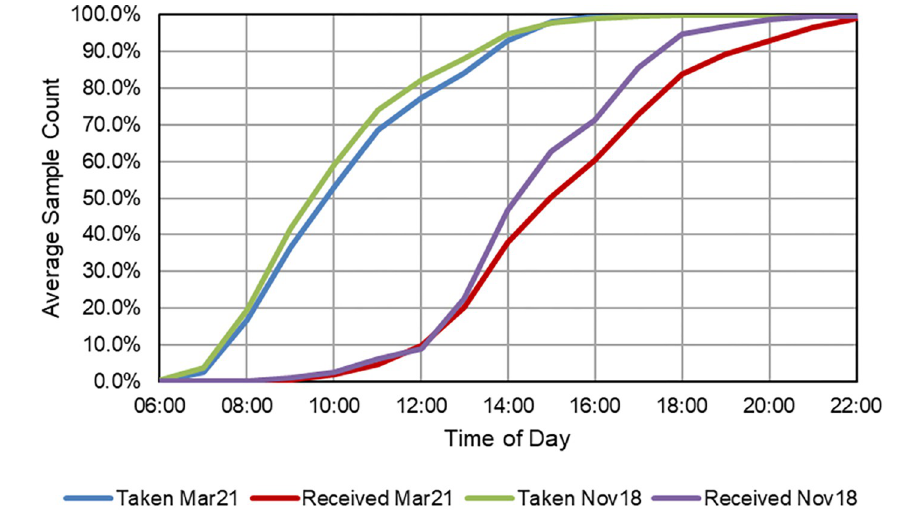
Fig 7. Plot of GP sample records for Southampton—"Bleed Time" (Time Taken) vs. Time Received at SGH laboratory. March 2021 and November 2018 datasets shown to demonstrate minimal long-term